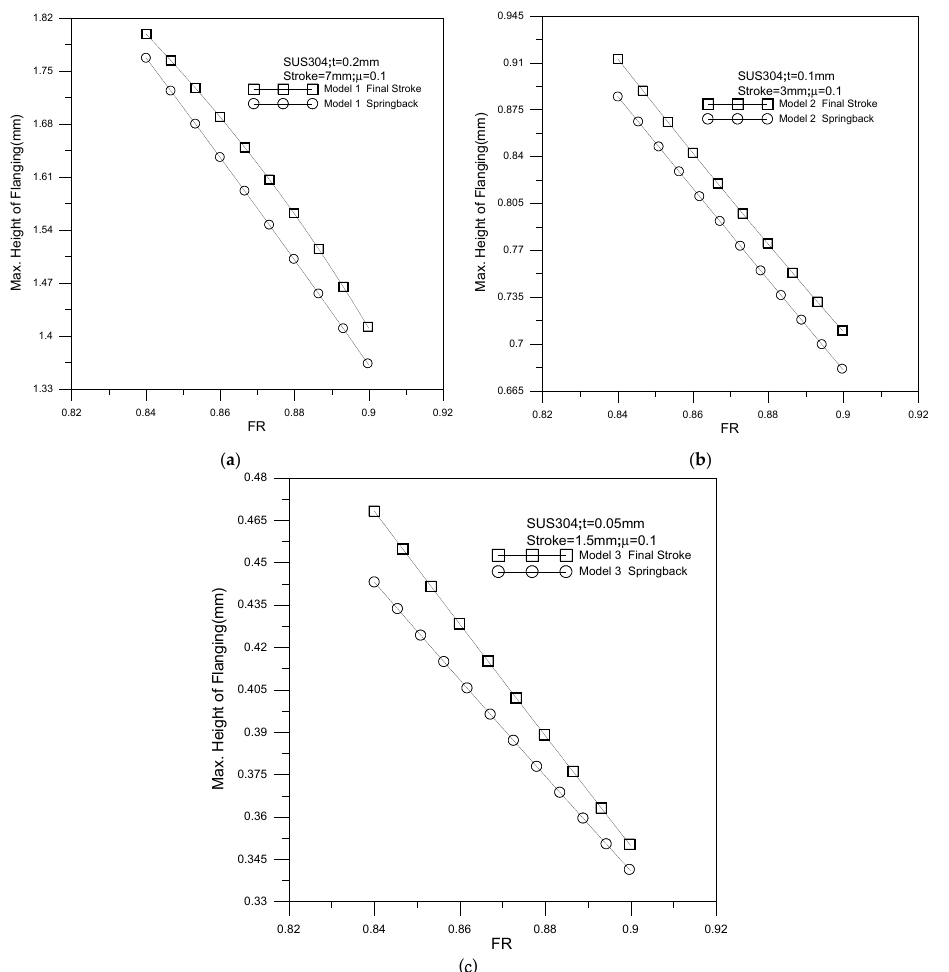
Figure 17. The relationship between the forming ratio and the maximum height of the flange: ( a ) Model 1; ( b ) Model 2; ( c ) Model 3. From the results above in Section 4.1 to 4.3 regarding Model 1, it is found that the average values of minimum flange thickness for variations of Br, Rp, and FR are 0.151, 0.148, and 0.143 mm, respectively, as shown in Table 8, and the maximum deviation ap- proaches 5.3%. For Models 2 and 3, the maximum deviations are close to 6.5 and 8.7%, respectively. Meanwhile, the results reveal that the average values of maximum dimension of the hole for Model 1 varies of Br, Rp, and FR are 5.09, 5.095, and 5.08 mm, respectively, as shown in Table 8, and the maximum deviation approaches 0.3%. For Models 2 and 3, the maximum deviations are close to 0.04 and 0.08%, respectively.